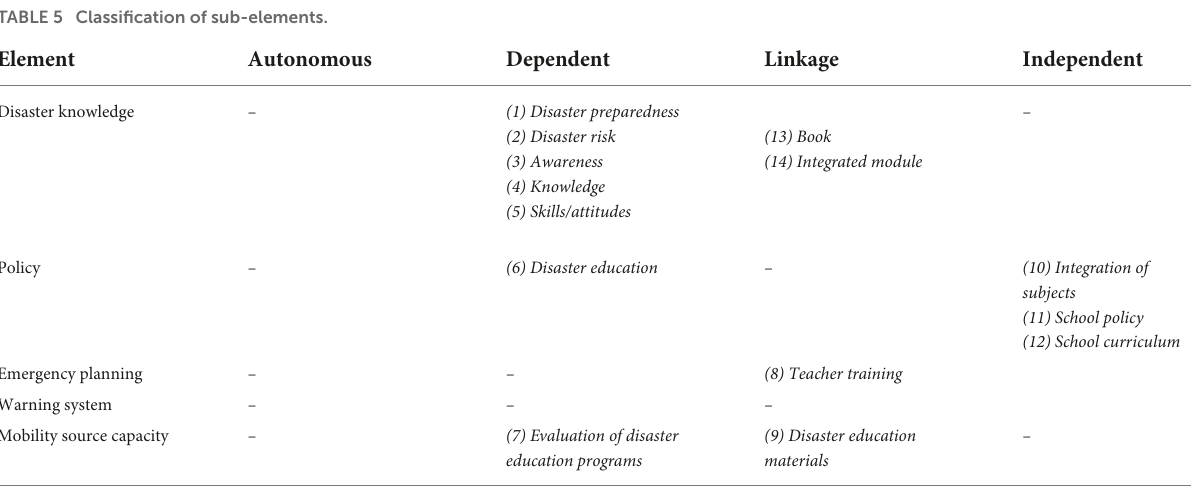
TABLE 5 Classification of